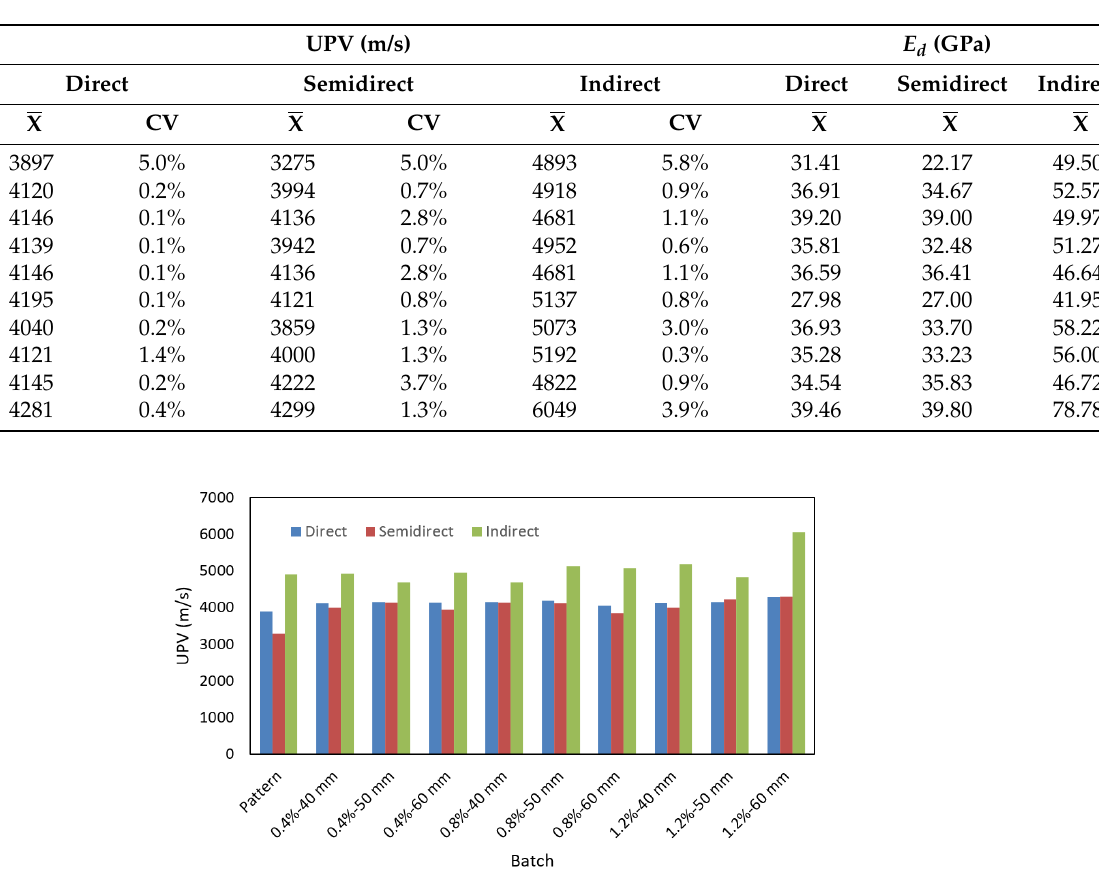
Table 4. Ultrasonic pulse velocity and the dynamic modulus of elasticity of concrete.